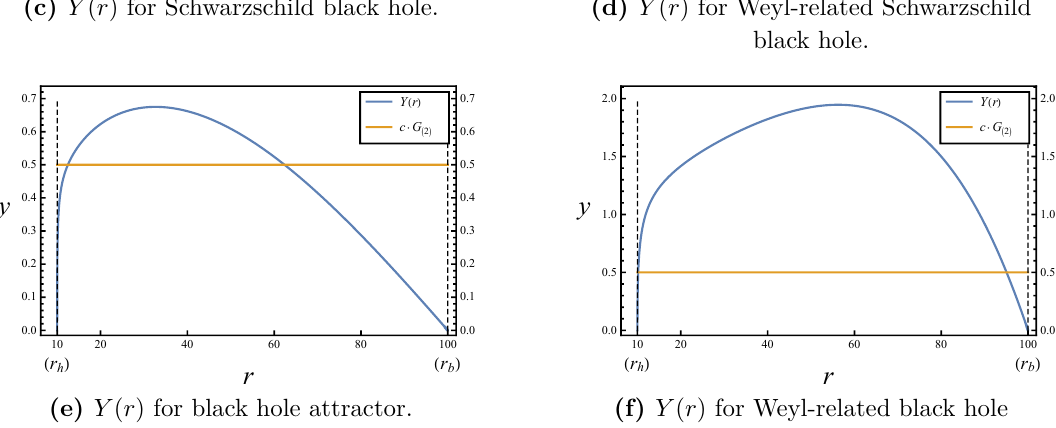
(f) Y ( r ) for Weyl-related black hole attractor.